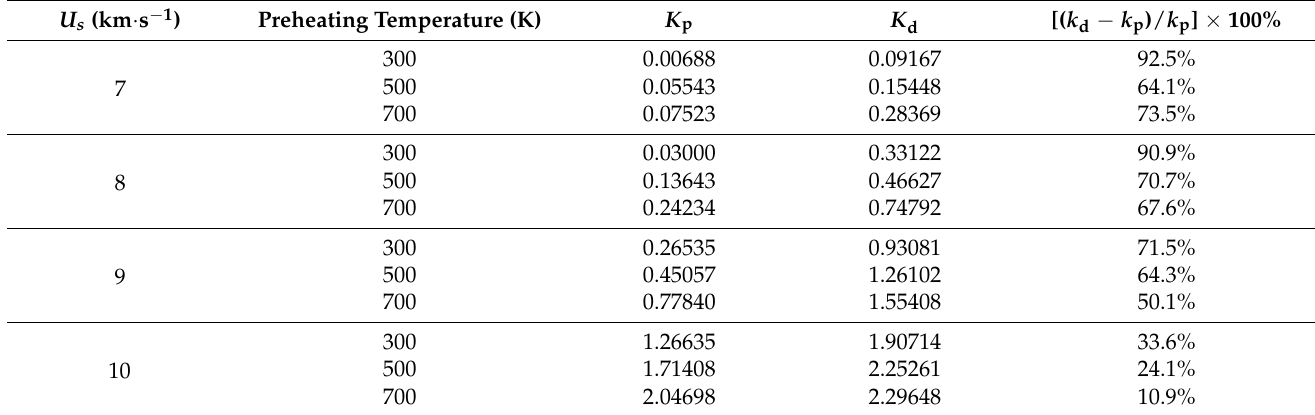
Table 1. Decomposition rate k (10 12 s − 1 ) of PETN molecules under the coupling effect of preheating, shock, and